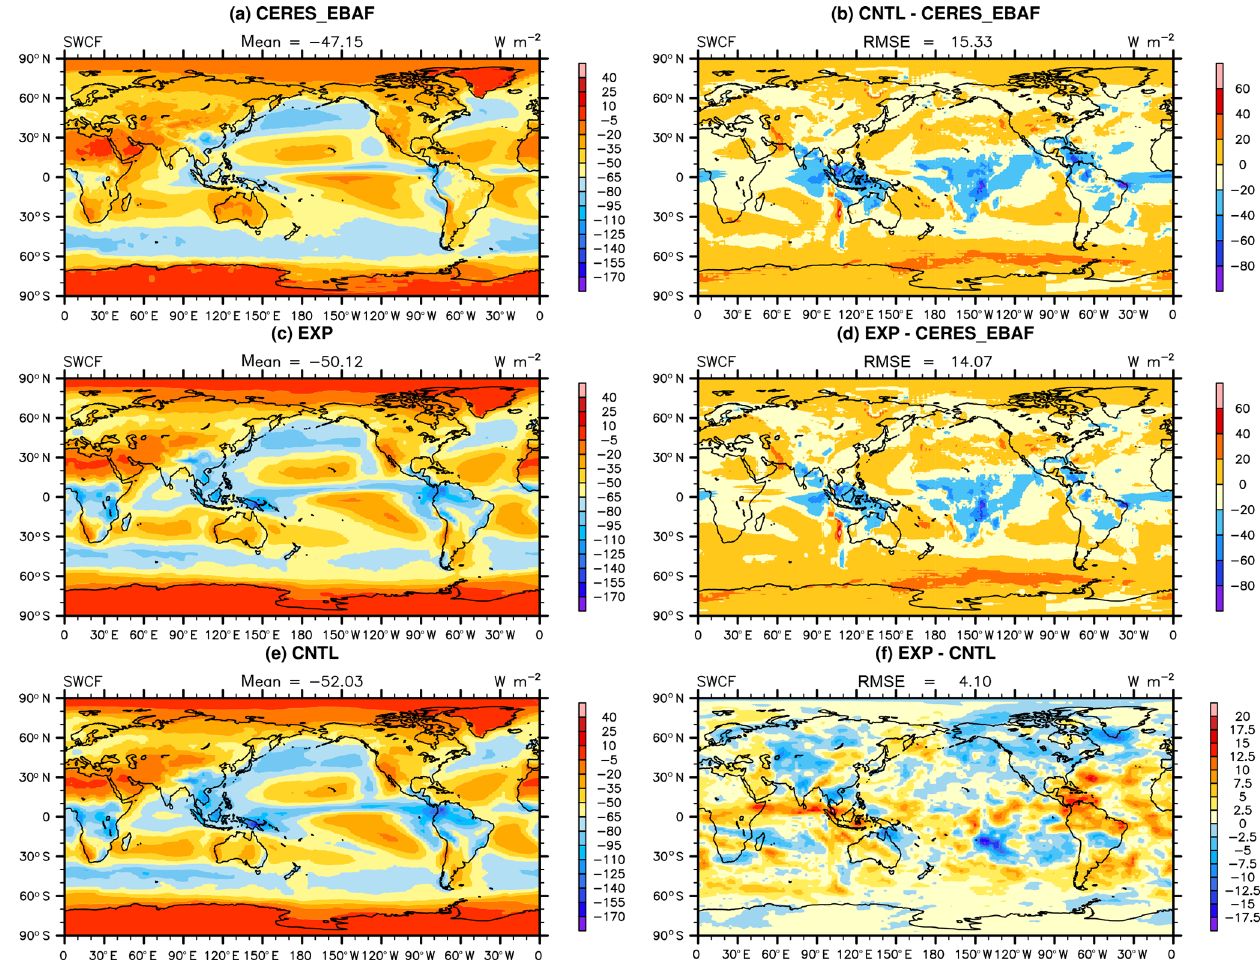
Figure 5. The spatial distribution of TOA SW cloud forcing of (a) observation, (b) CNTL–observation, (c) EXP, (d) EXP–observation, (e) CNTL, and (f) EXP–CNTL.